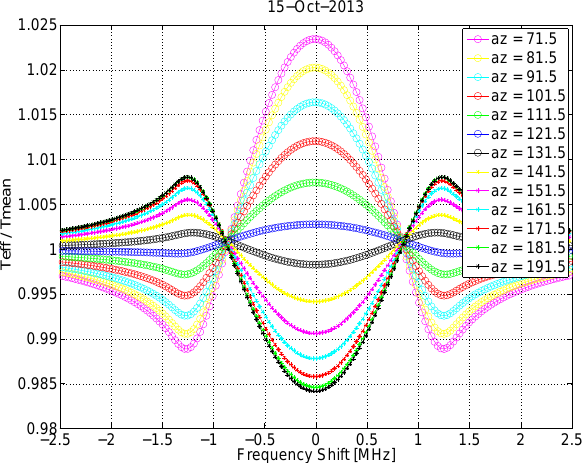
Figure 9. Ratio between the effective temperature for each obser- vational angle and the averaged spectra for ARTS